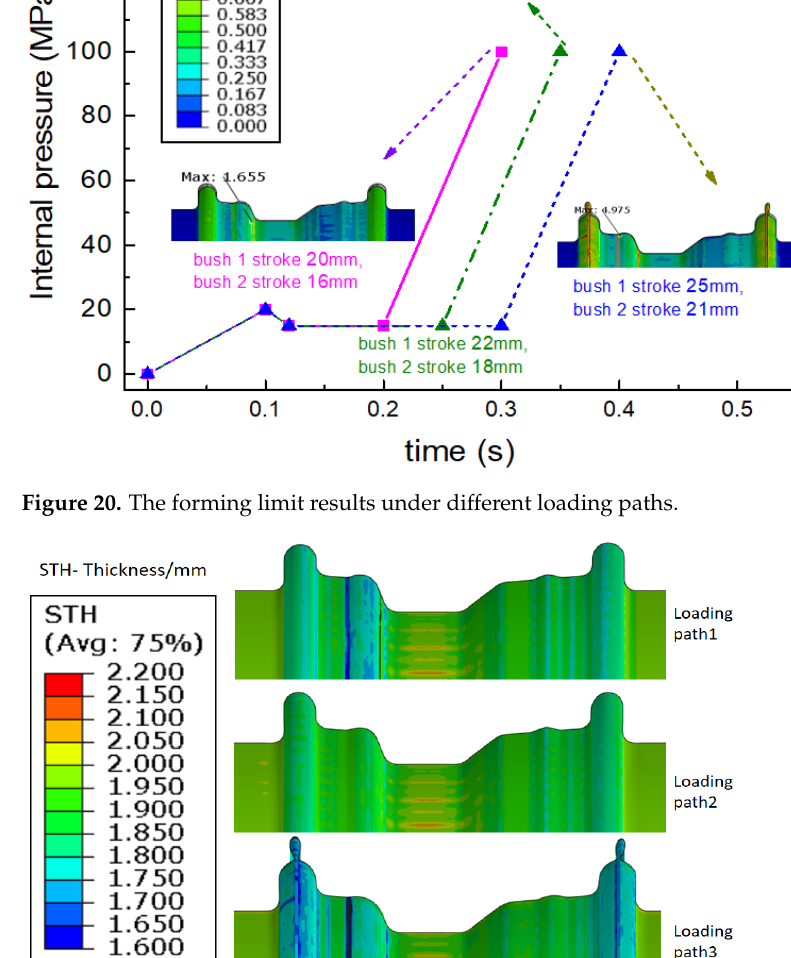
Figure 22. Wrinkling in experiments under the external pressure forming stage.